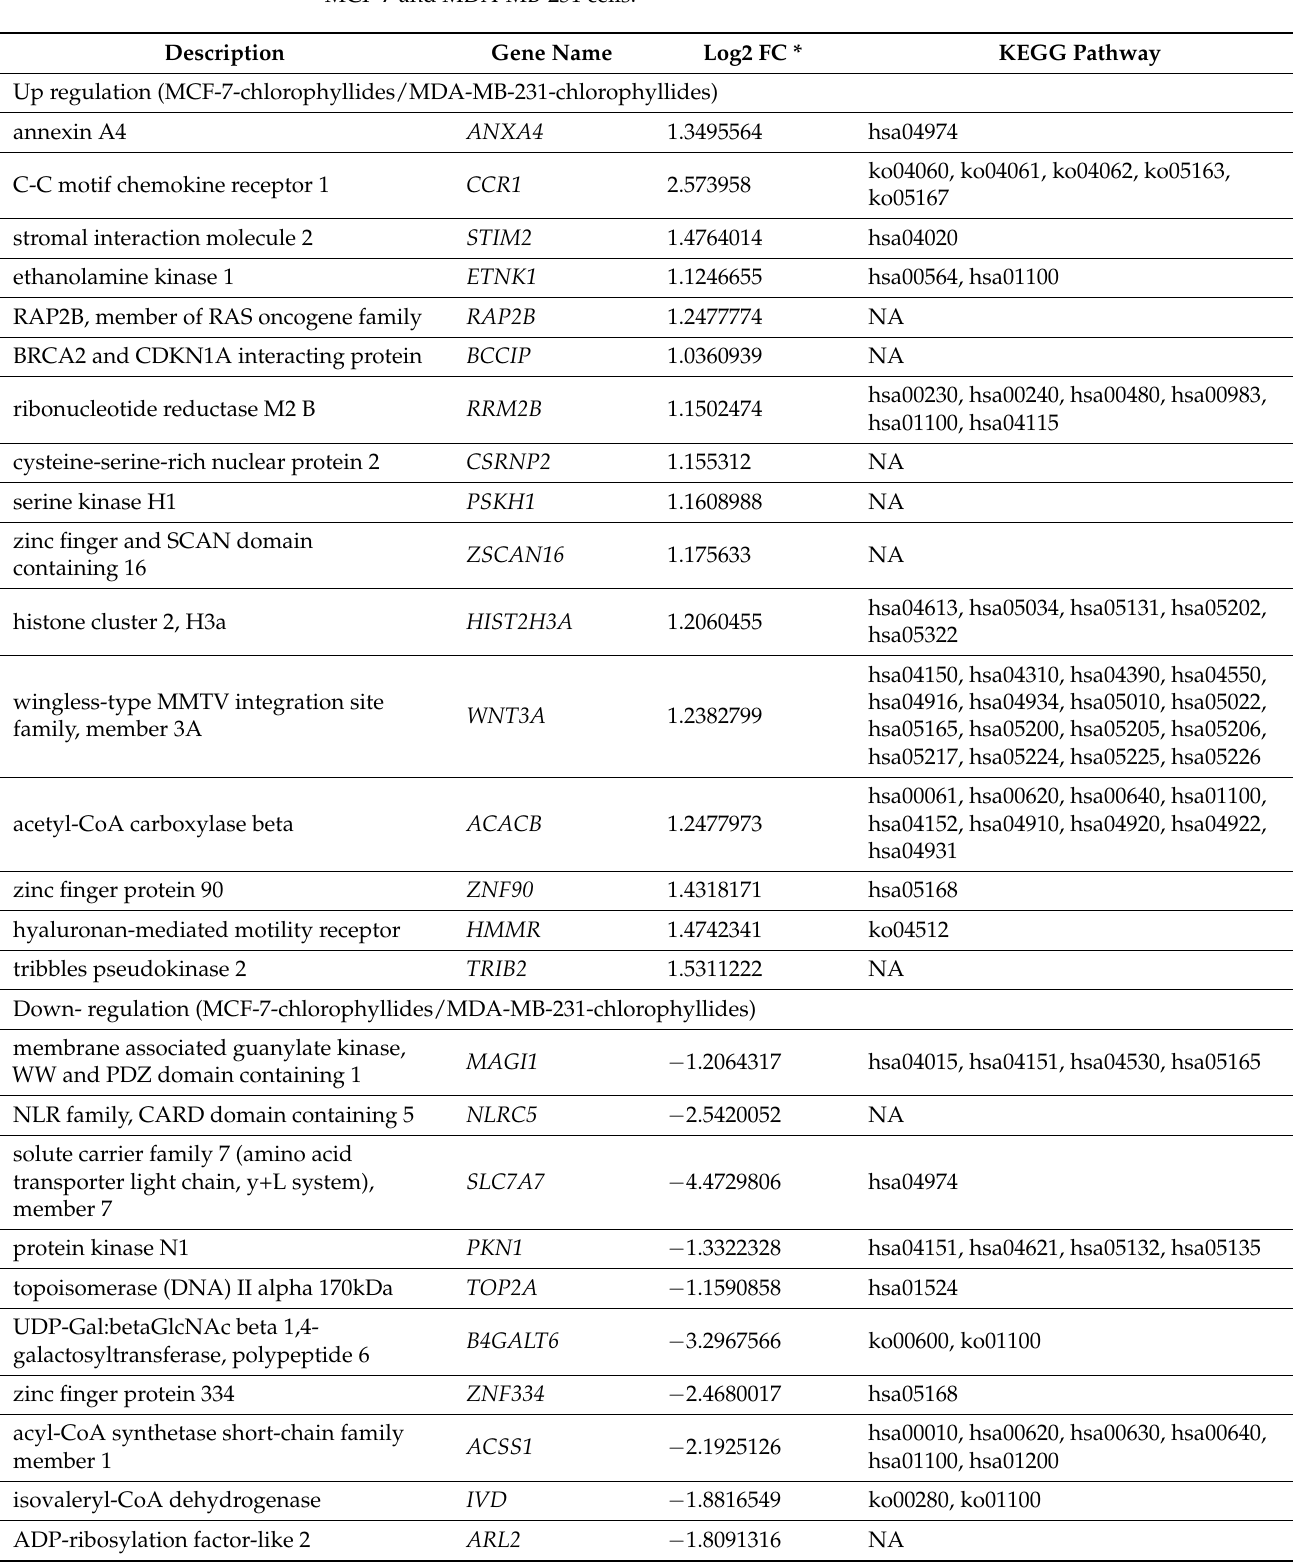
Table 4. Differentially expressed genes (DEGs) regulate after chlorophyllides treatment between MCF-7 and MDA-MB-231